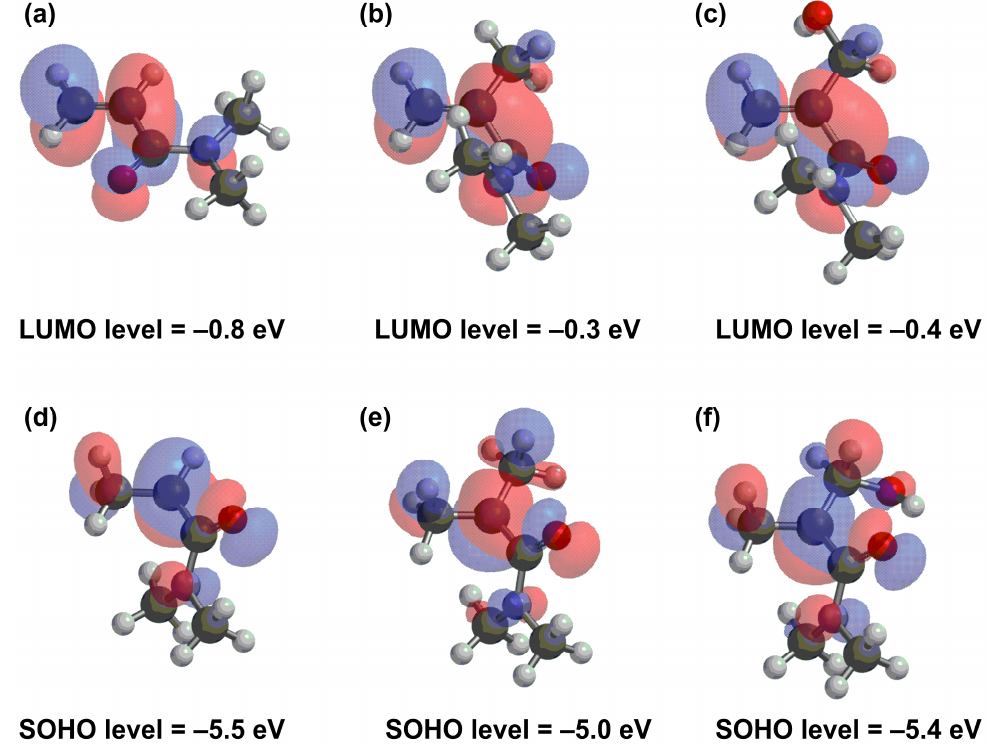
Figure 1. LUMOs of ( a ) DMAA, ( b ) DMMA and ( c ) DM α HAA, and SOHOs of the respective radicals to ( d ) DMAA, ( e ) DMMA and ( f ) DM α HAA, by DFT calculation (B3LYP/6-31G*).